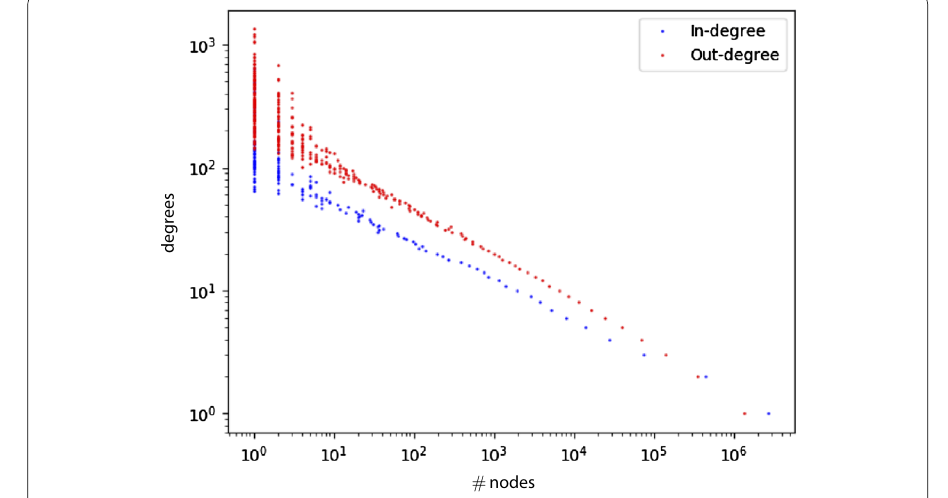
Fig. 1 Degree distribution of organizations ( Orbis )